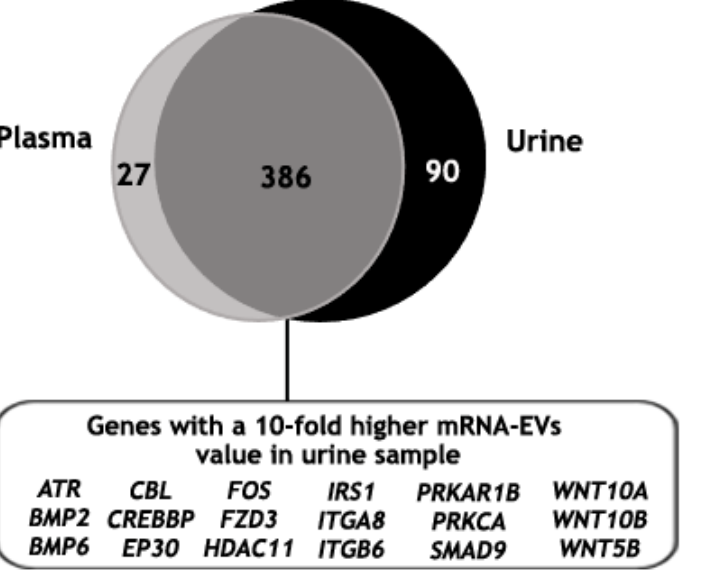
Figure 7. Identified genes above the threshold value in plasma and urine mRNA-EVs samples from an mPC patient, represented in a Venn diagram showing 386 common genes, of which 20% resulted in a 10-fold higher expression in EV-mRNA from mPC urine sample compared to the EV-mRNA mPC plasma sample. This set of genes was involved mainly in molecular mechanism of cancer pathways where ATR, BMP2, BMP6, CBL, CREBBP, EP30, FOS, FZD3, HDAC11, IRS1, ITGA8, ITGB6, PRKAR1B, PRKCA, SMAD9, WNT10A, WNT10B and WNT5B were represented.